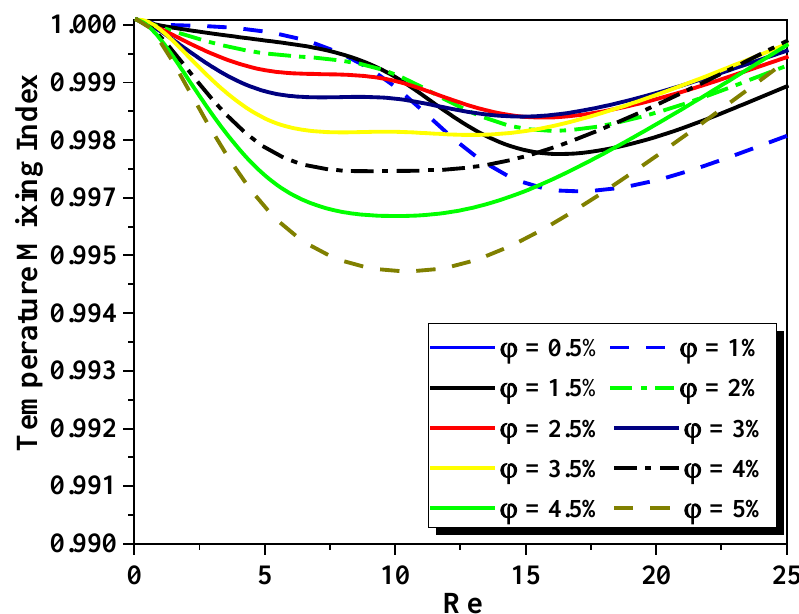
Figure 14. Improvement of thermal mixing performance for different generalized Reynolds numbers for variation cases of nanofluid concentrations (φ = 0.5 to 5%).